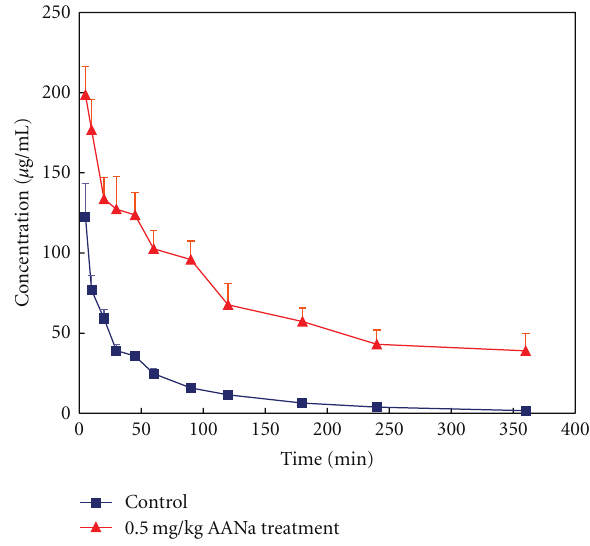
Figure 2: Plasma concentrations of inulin after iv administration of 0.5mg/kg aristolochic acid sodium (AANa) to rabbits ( n =